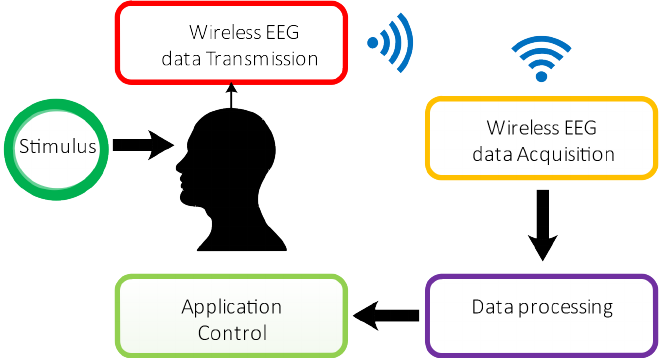
Figure 1. BCI data acquisition and control block diagram.